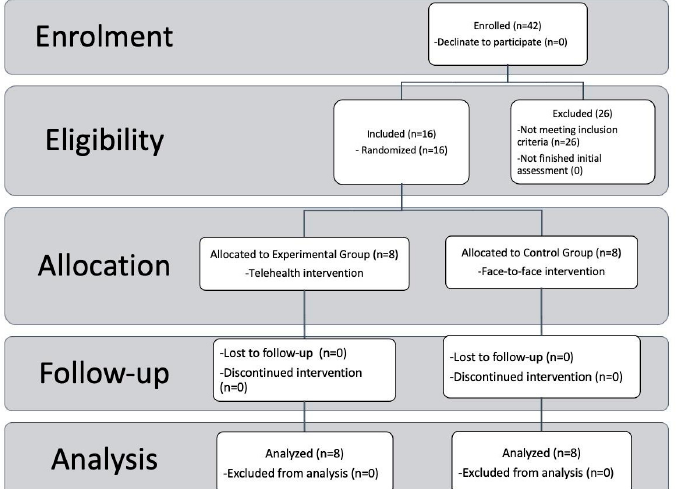
Figure 1. Subject recruitment assignment, and assignment procedures. CONSORT Flow diagram showing the phases of a parallel randomized trial of two groups of ASD individuals underwent telehealth (experimental group) or traditional (control) interventions.